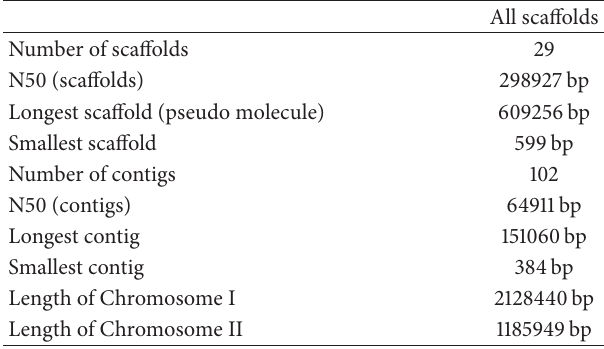
Table 1: Genome assembly statistics for Bm IND1 genome.